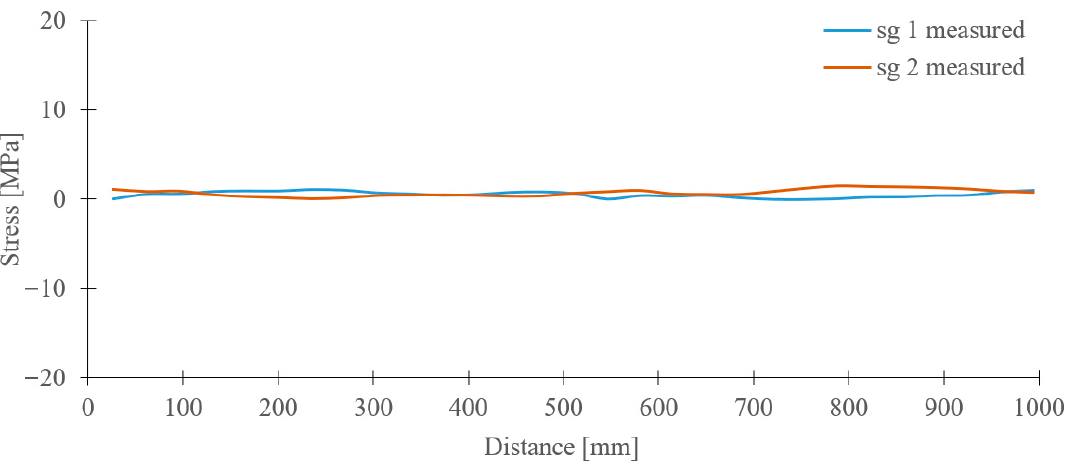
Figure 10. Course of stress values in the crane bridge construction during traveling of the crane without skewing.